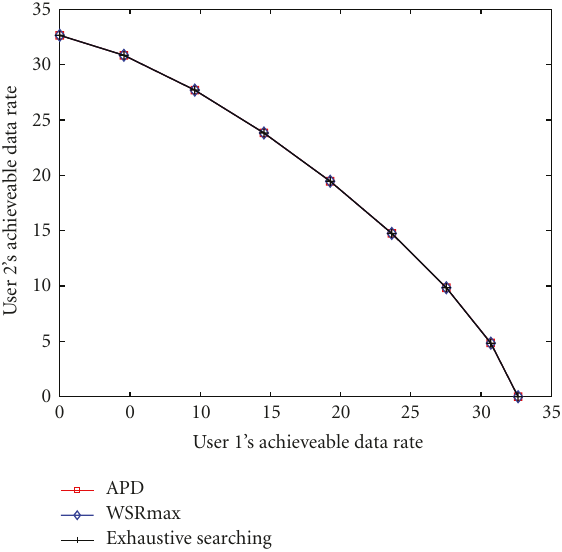
Figure 4: Probability of missing global optimum versus iterations for K = 2 users, M = 8 subcarriers, and SNR = 10dB.